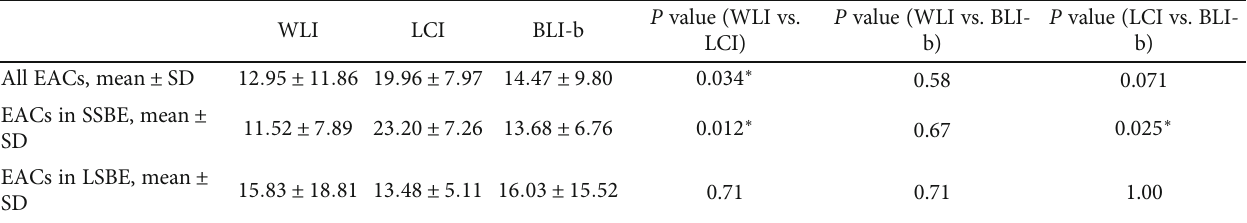
Table 5: The color di ff erences ( Δ E ∗ ) of EAC from the adjacent normal Barrett ’ s mucosa in WLI, LCI, and BLI-b modes. WLI LCI